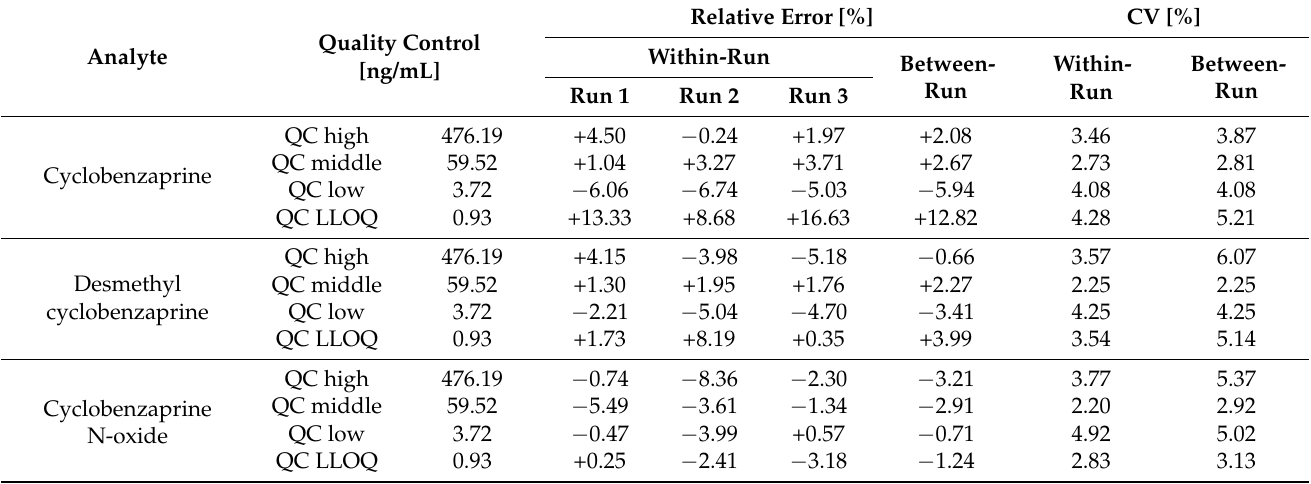
Table 3. Summary of accuracy and precision results for cyclobenzaprine, desmethyl cyclobenzaprine and cyclobenzaprine N-oxide (accuracy presented as mean relative error and precision as coefficient of variation, n = 5 per run). CV, coefficient of variation; LLOQ, Lower limit of quantification; QC, quality